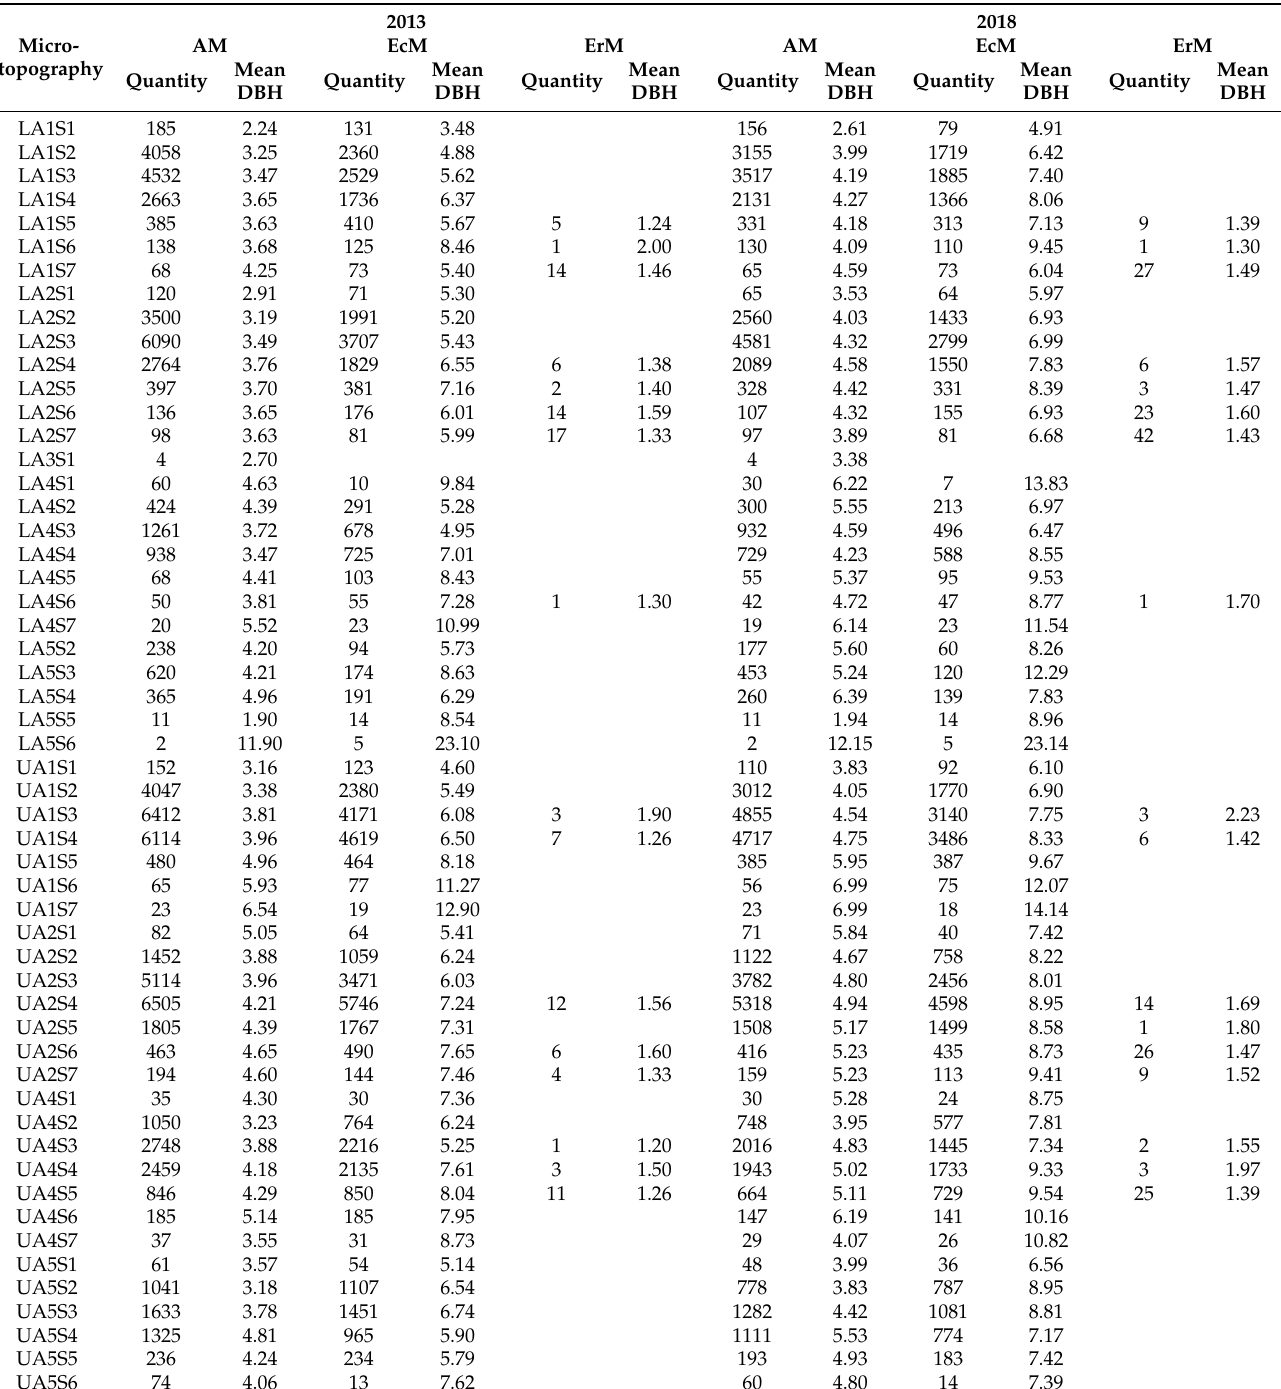
Table A3. The quantity and mean DBH of tree species with different mycorrhizal types in different